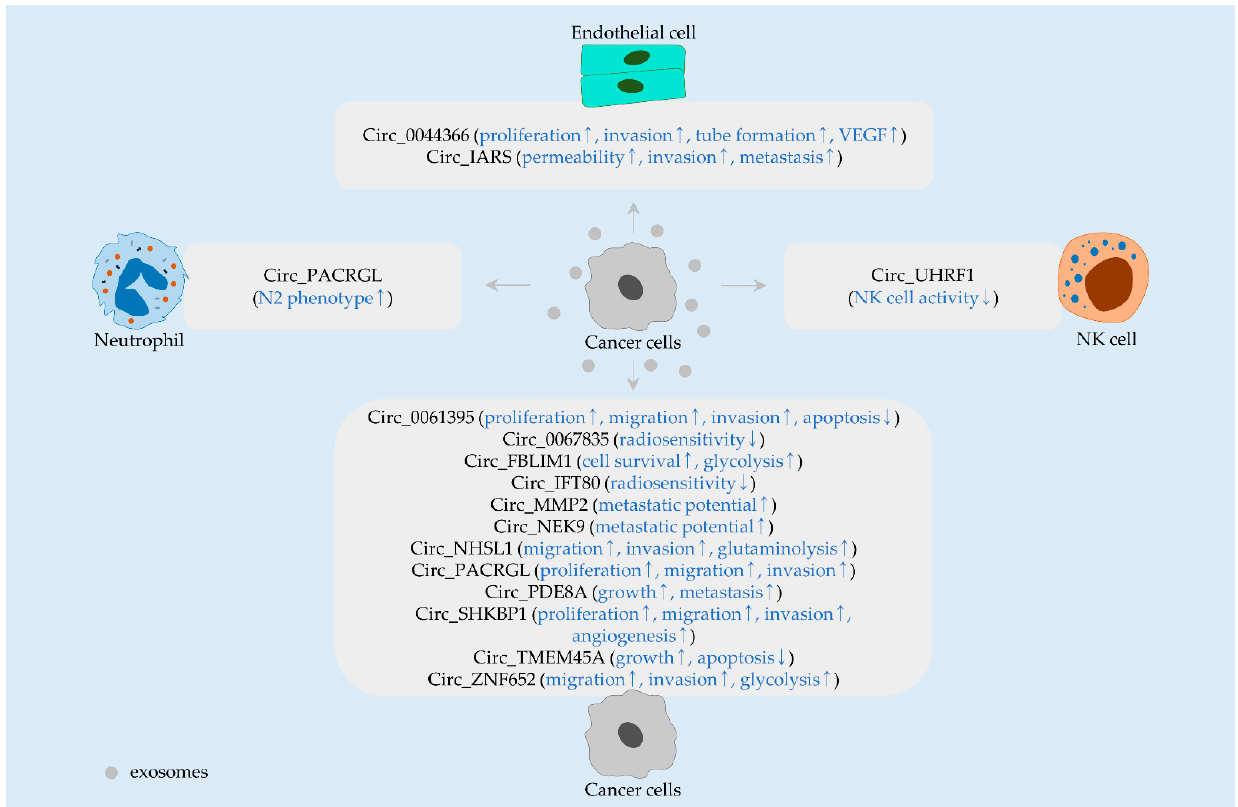
Figure 2. Exosomal circRNAs released from cancer cells and their effects in recipient cells. CircRNAs (black), and their biological functions (blue) are denoted in rounded rectangles. Arrows indicate the upregulation ( ↑ ) and downregulation ( ↓ ).